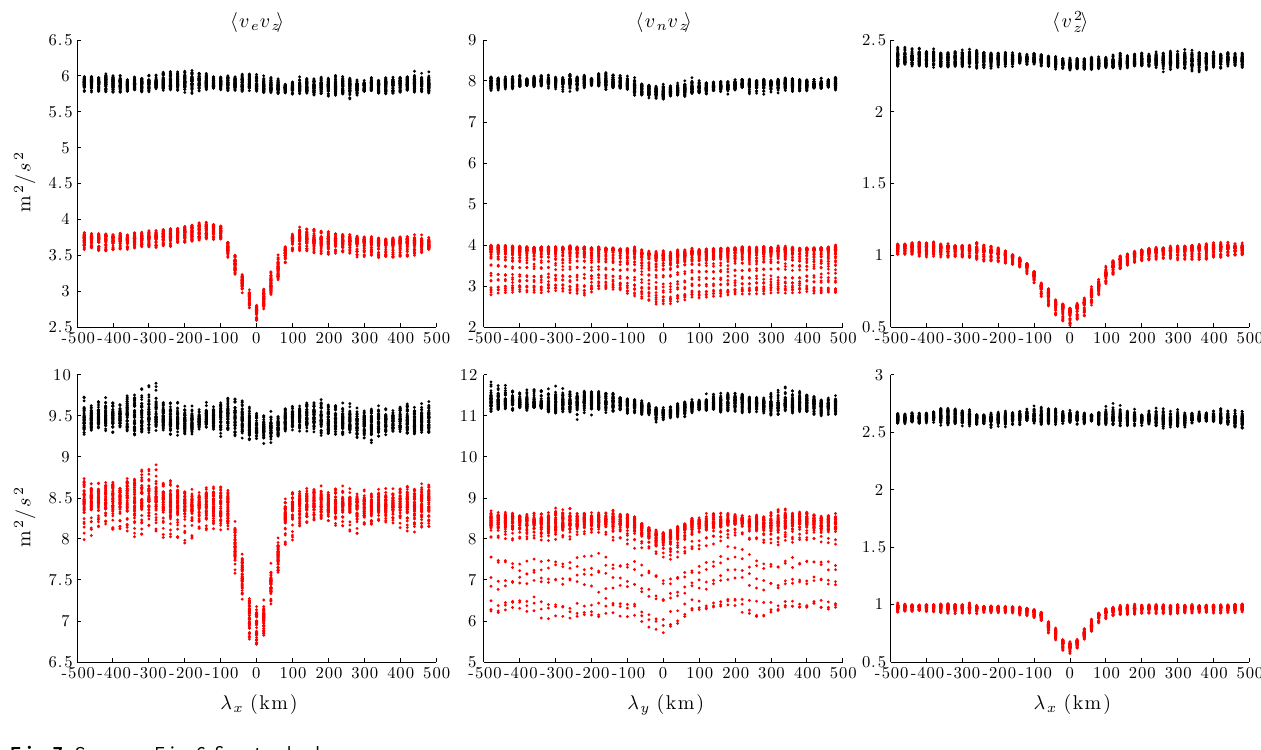
Fig. 7. Same as Fig. 6 for standard errors. Table 2. Background winds, gravity wave parameters, and corresponding wind variances and momentum fluxes for the simulation in Sect. 3.3.